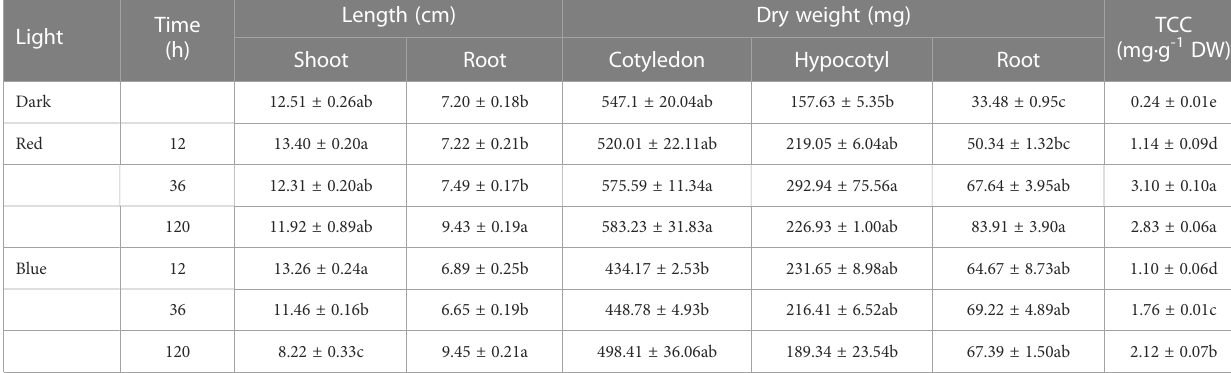
TABLE 1 Length, dry weight, and total chlorophyll content in soybean seedlings grown under darkness, red (650 nm), and blue (447 nm) light.